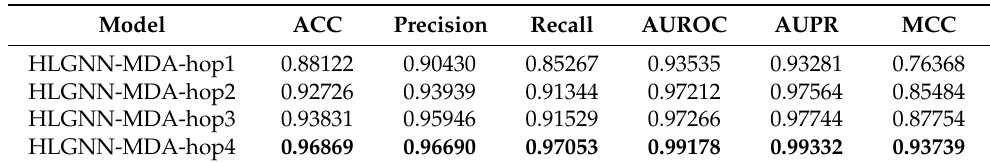
Table 2. Influence of different hops in enclosing subgraphs on HLGNN-MDA. The bold part indicates the maximum value in the corresponding column.